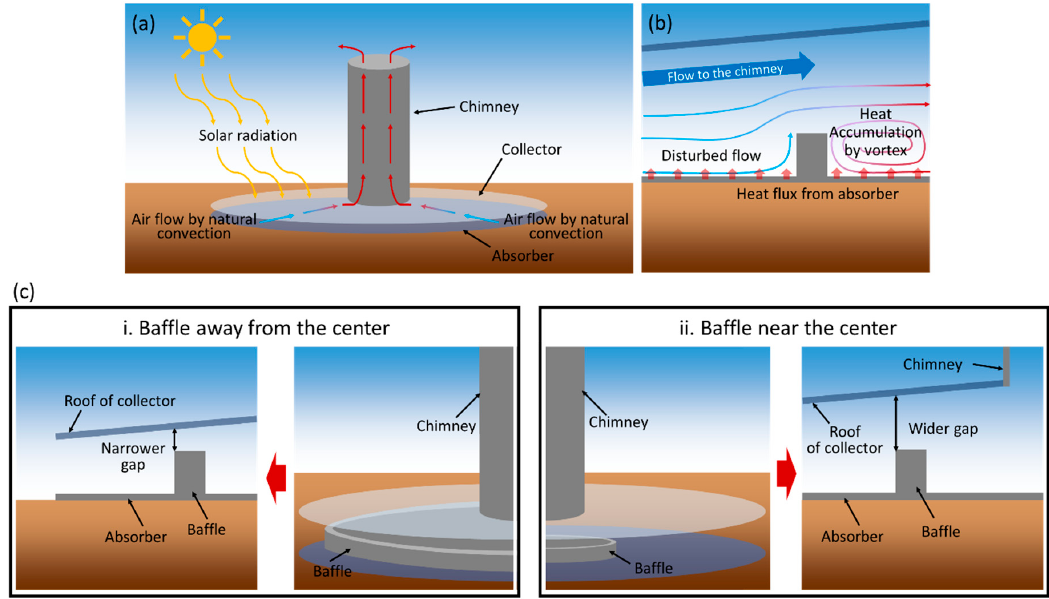
Figure 1. A schematic of the effects by baffle distance from the center in a solar updraft tower (SUT): ( a ) The overall view of the SUT showing each component and the basic principles of the SUT. ( b ) Two major effects of baffle in the SUT: disturbed flow and heat accumulation by vortex. ( c ) A comparison of the effects in terms of the baffle distance: (i) the case where the baffle is far from the center and (ii) the case where baffle is near the center.